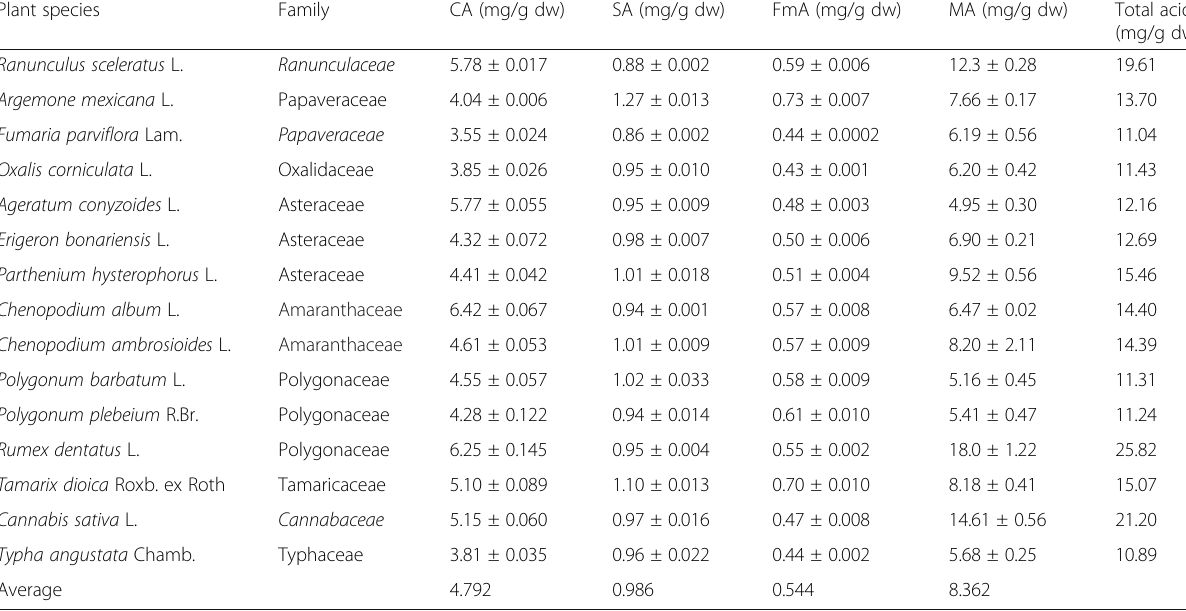
Table 1 Mean and standard deviation ( n = 3) of organic acids in the leaves of plants collected from catchment areas of the river Beas Plant species